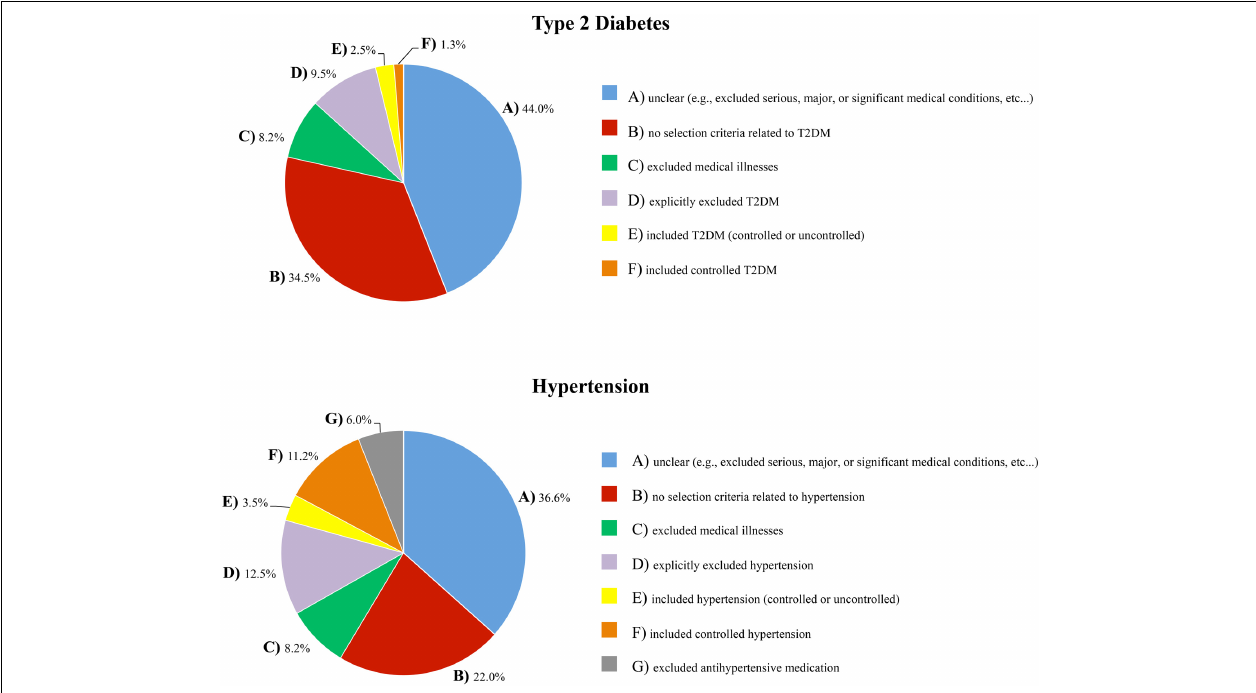
FIGURE 2 | The extent to which T2DM and hypertension were accounted for in the inclusion/exclusion criteria of the healthy samples that were